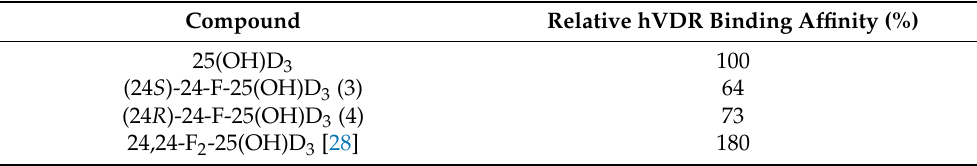
Table 1. Relative hVDR binding affinity of 24-fluorinated 25(OH)D 3